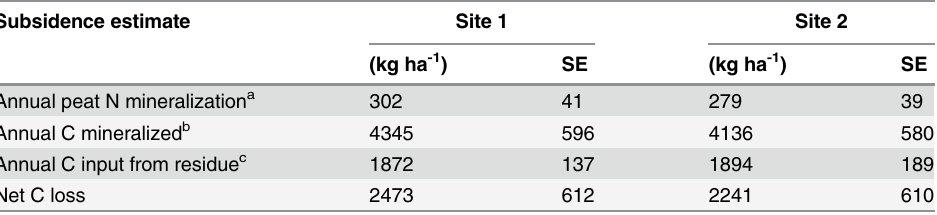
Table 6. Soil C loss estimate based on annual peat N mineralization and assuming a nitrogen uptake efficiency (NUE) of 50%. Subsidence